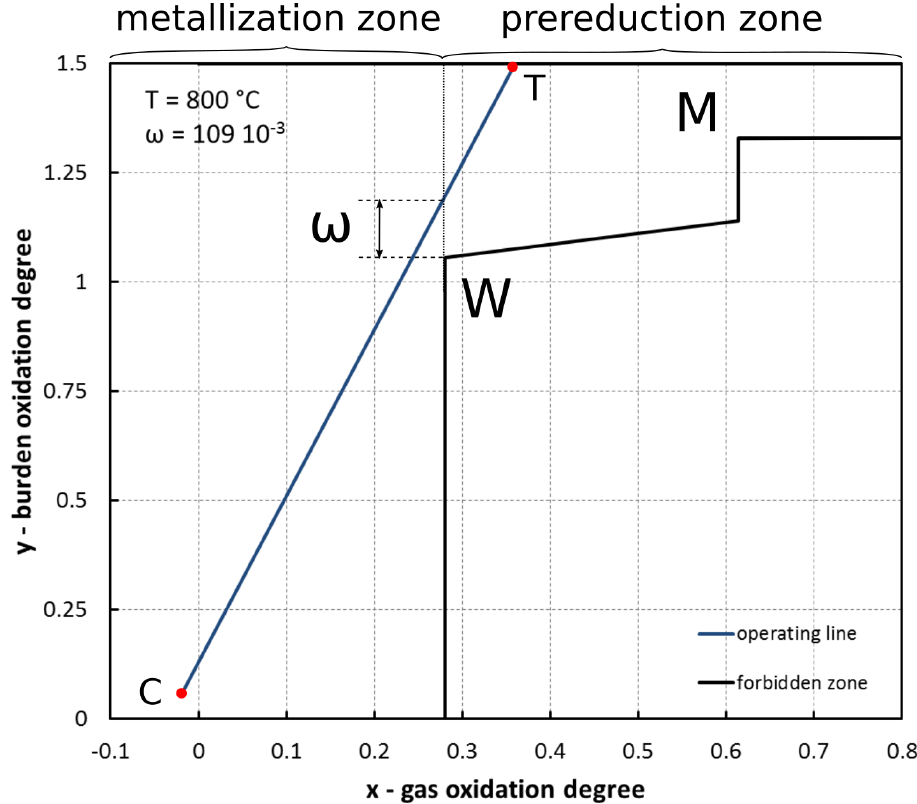
Figure 4. Operating diagram for Midrex NG TM module 2 in ArcelorMittal Contrecoeur plant on April 2016, assuming 100% in situ reforming in the metallization